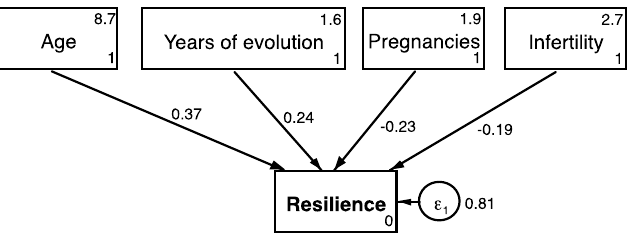
Figure 1. Structural predictive best fitting model.